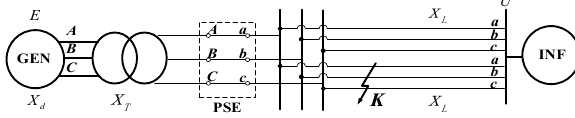
Figure 1. Diagram of the single machine infinite system.